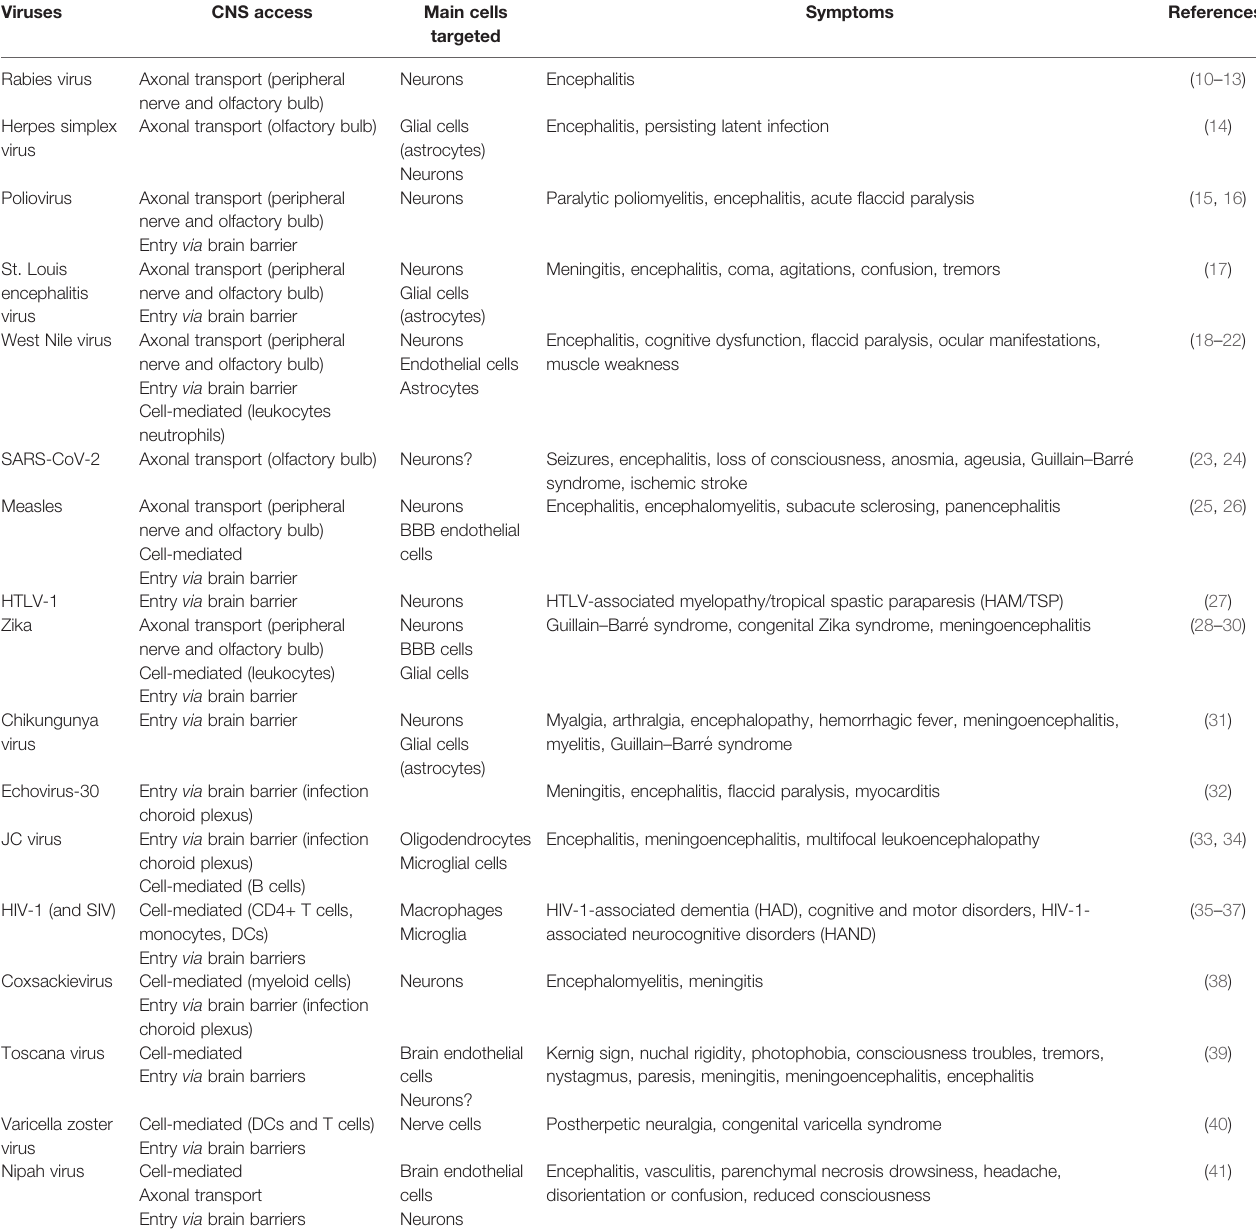
TABLE 1 | Different CNS mechanism access and symptoms for some neurotropic